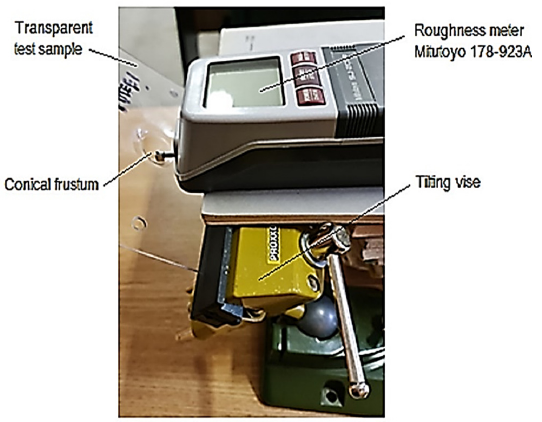
Figure 5. Setup used to measure the values of the roughness parameter Ra corresponding to the internal surfaces of the conical trunks.